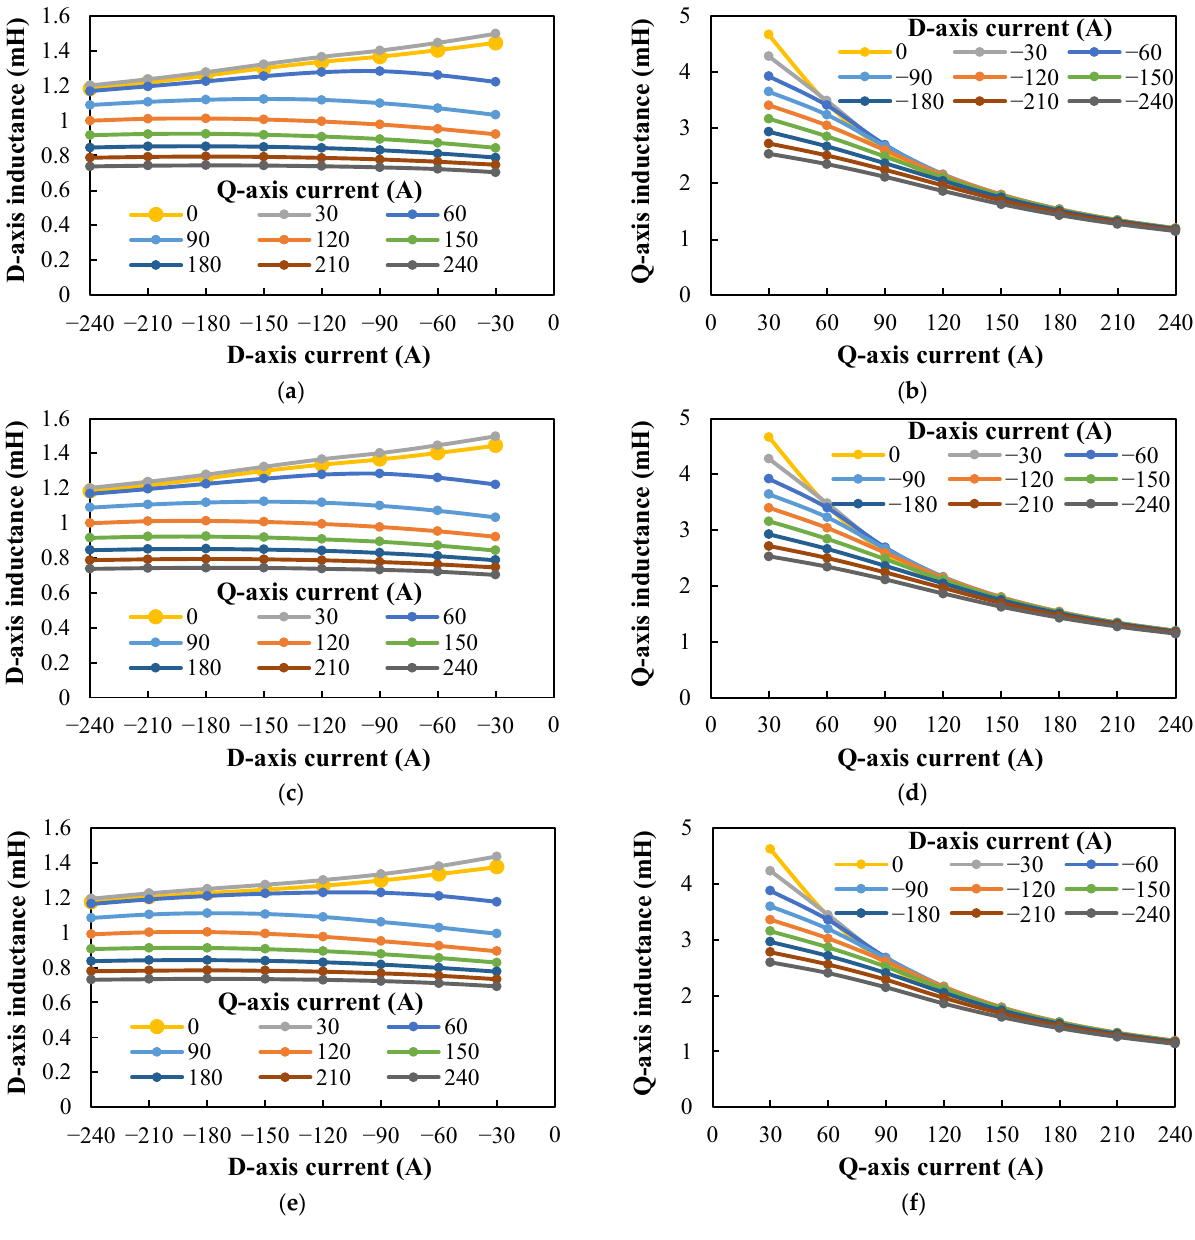
Figure 26. Variations of d- and q-axis inductances with different winding configurations and different d- and q-axis current combinations: ( a ) ORG: d-axis inductance; ( b ) ORG: q-axis inductance; ( c ) DTP-SF: d-axis inductance; ( d ) DTP-SF: q-axis inductance; ( e ) DTP-DS: d-axis inductance; ( f ) DTP-DS: q-axis inductance.